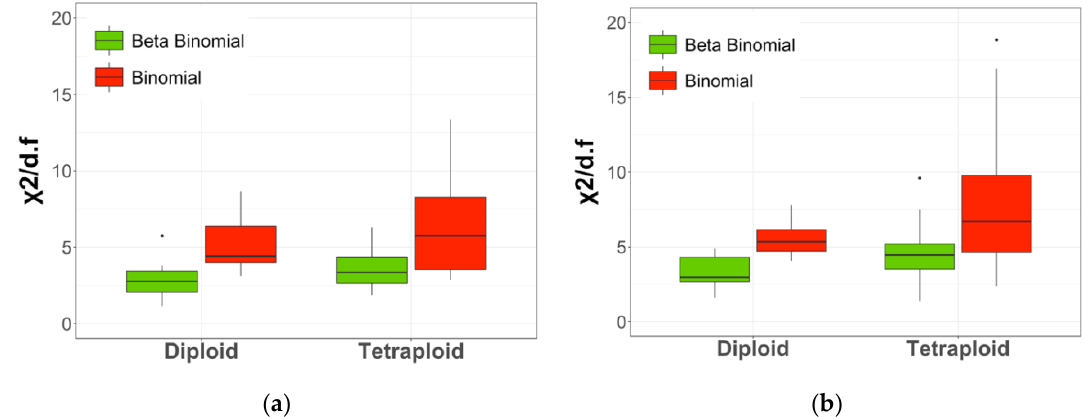
Figure 3. The boxplot of ˆ χ 2 / df for the goodness-of-fit test between the observed and expected numbers of sequence reads under two alternative distributions at two coverages (20–60 on the left ( a ) and 60–100 on the right ( b )) from diploid and tetraploid potato.